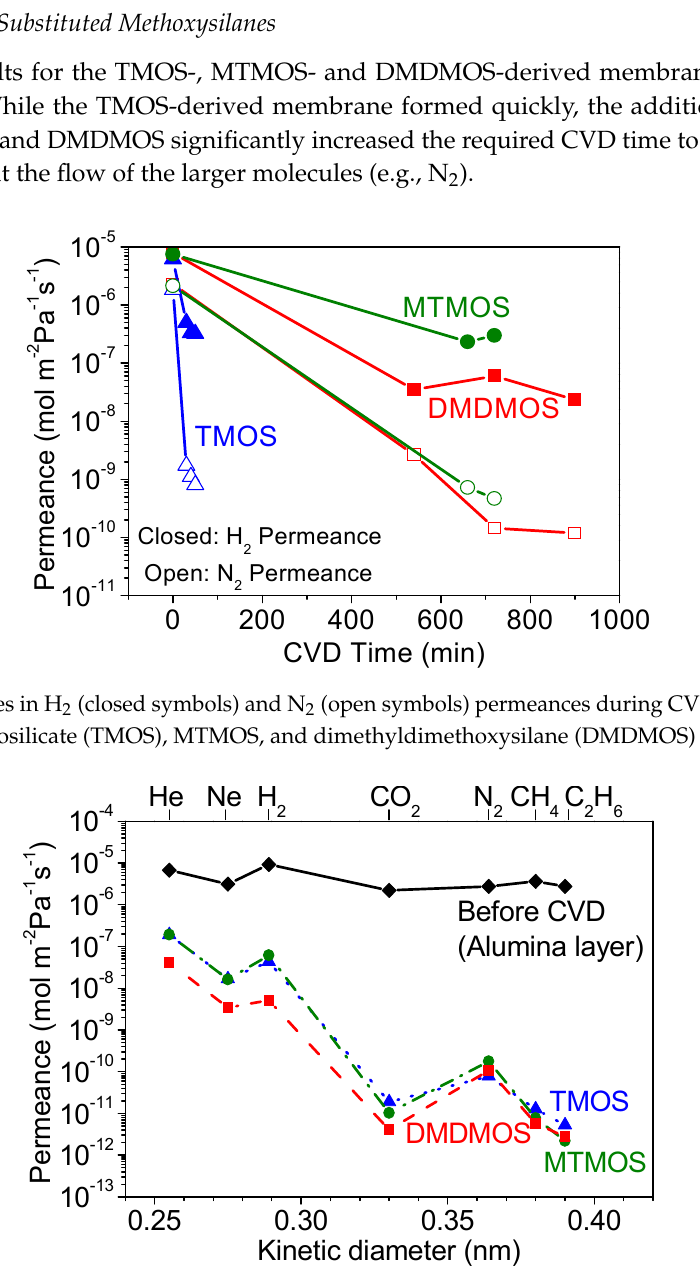
Table 2. Summary of the membrane performance at 300 ◦ C, and deposition conditions of the MTMOS-derived membranes deposited with residence times of 0.4 s, 0.8 s, and 1.3 s.